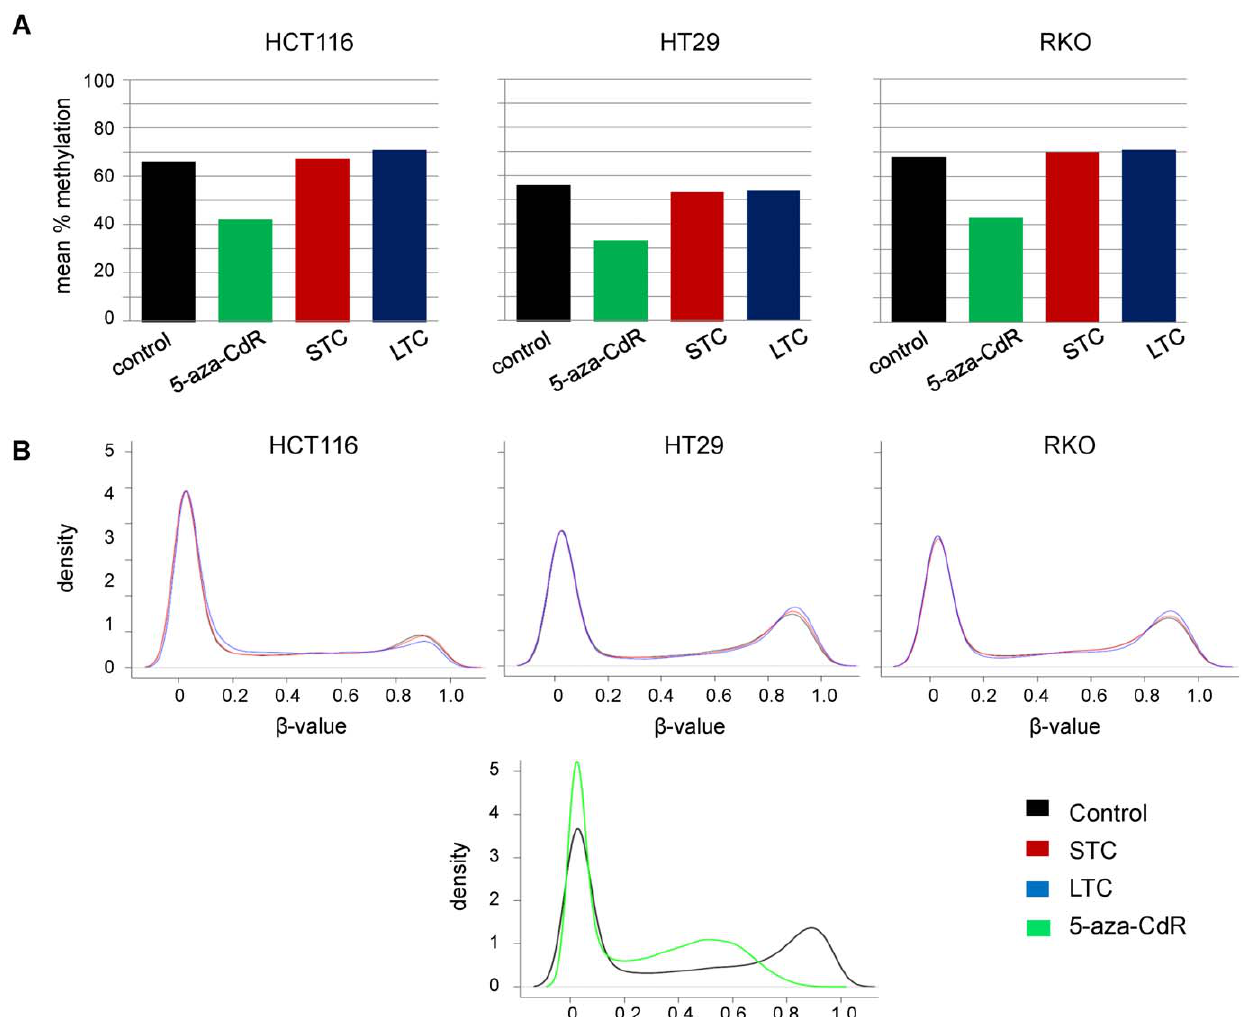
Figure 3. Curcumin treatment is not associated with changes in methylation status of long interspersed nuclear elements-1 (LINE-1) that serve as surrogate markers for global DNA methylation. (A) HCT116, RKO and HT29 were treated with 5-aza-CdR and curcumin and LINE-1 methylation status was determined using bisulfite pyrosequencing. (B) To assess changes in global methylation patterns, density plots were calculated for controls, 5-aza-CdR and curcumin-treated cell lines using Infinium global methylation microarrays. While 5-aza-CdR was responsible for a shift in CpG methylation towards hypomethylation, methylation pattern of the cells after curcumin treatment remained unchanged. Abbreviations: 5-aza-deoxycytidine (5-aza-CdR), short-term curcumin treatment (STC), long treatment with curcumin (LTC).